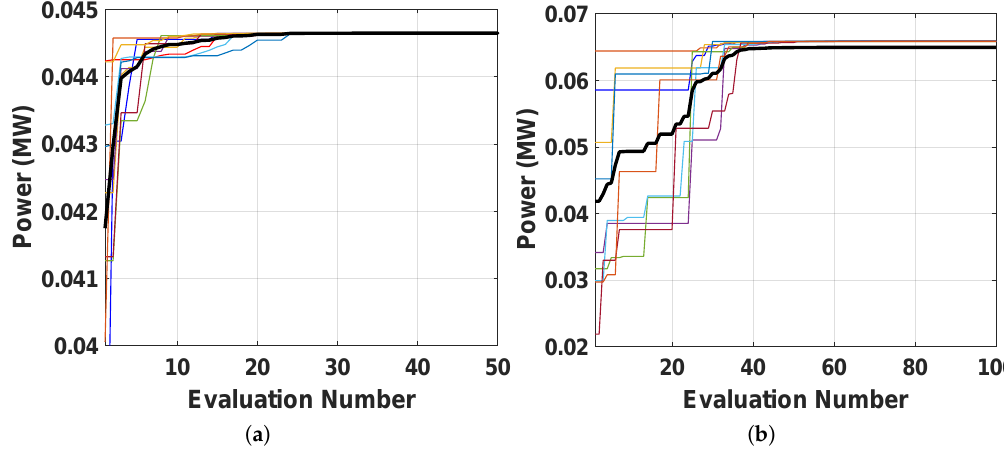
Figure 6. The effect of computational budget on tuning the local search iterations. ( a ) dimension optimisation ( a , H ) , ( b ) Tether angles optimisation ( α t , α ap